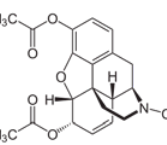
Figure 8. Heroin. Adapted from Ref. 21.